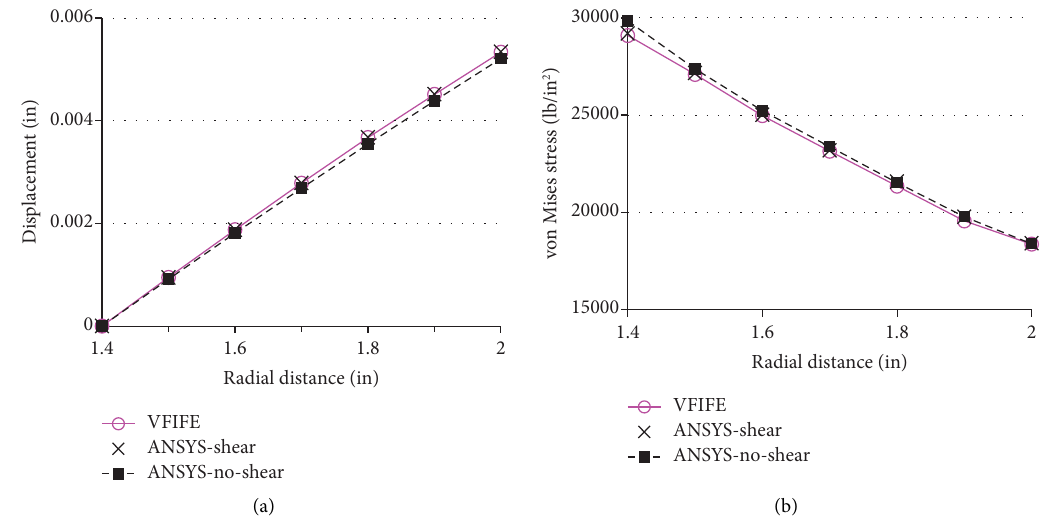
Figure 6: Results of the radial nodes along the radial direction. (a) Vertical displacement. (b) Von mises stress (SNEG